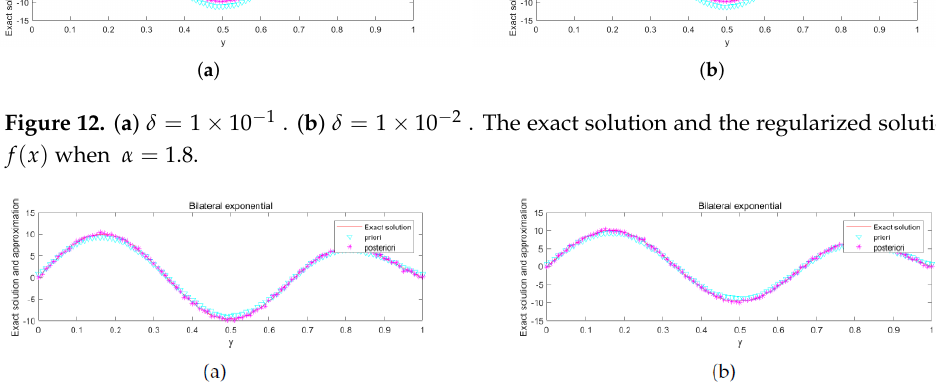
Figure 13. ( a ) δ = 0.5, α = 1.4 . ( b ) δ = 0.5, α = 1.8 . The exact solution and the regularized solution of f ( x ) .